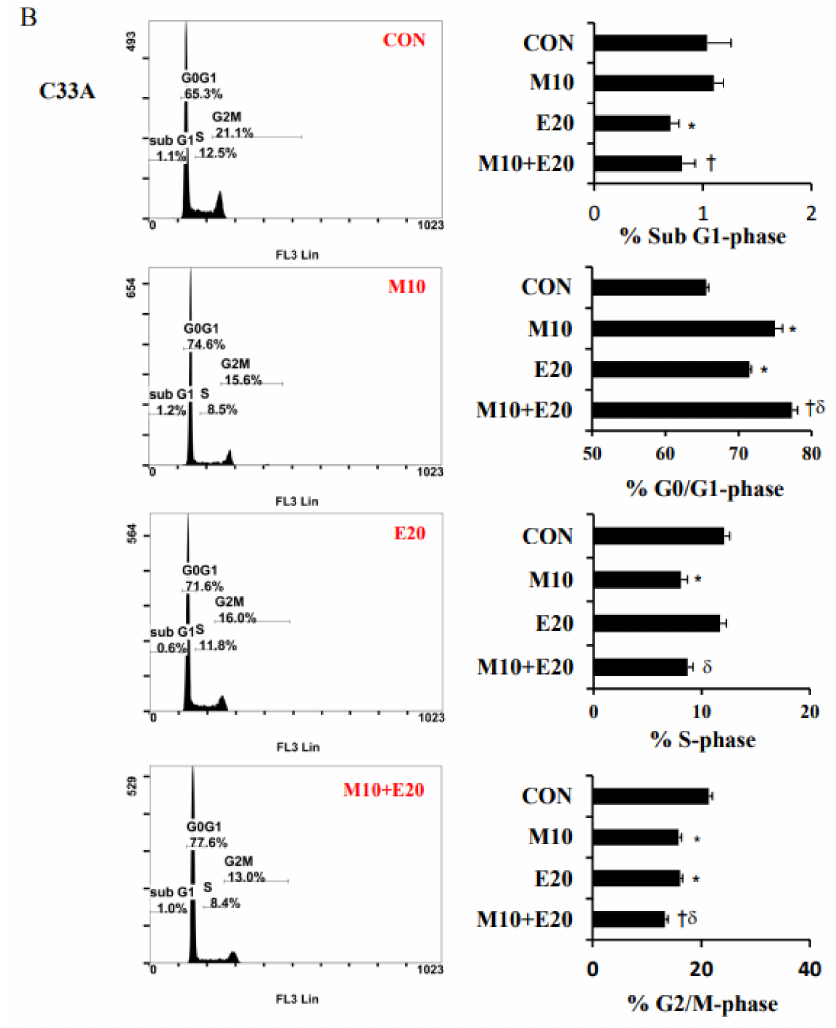
Figure 3. Metformin and everolimus arrested the cell cycle in the sub-G1 and G0/G1 phases. ( A ) CaSki and ( B ) C33A cells were treated with metformin (10 mM) with or without everolimus (20 µ M) for 48 h. Cell-cycle progression was assessed using a PI assay via flow cytometry. Quantitative results for the cell-cycle phase distribution (sub-G1, G0/G1, S, and G2/M phases) are presented in the bottom plot. Values represent the mean ± SD from three replicates. *, † and δ p < 0.05 compared with the CON, Met 10- or Eve 20-treated groups. CON, 0.1% DMSO; M10, 10 mM metformin; E20, 20 µ M everolimus.